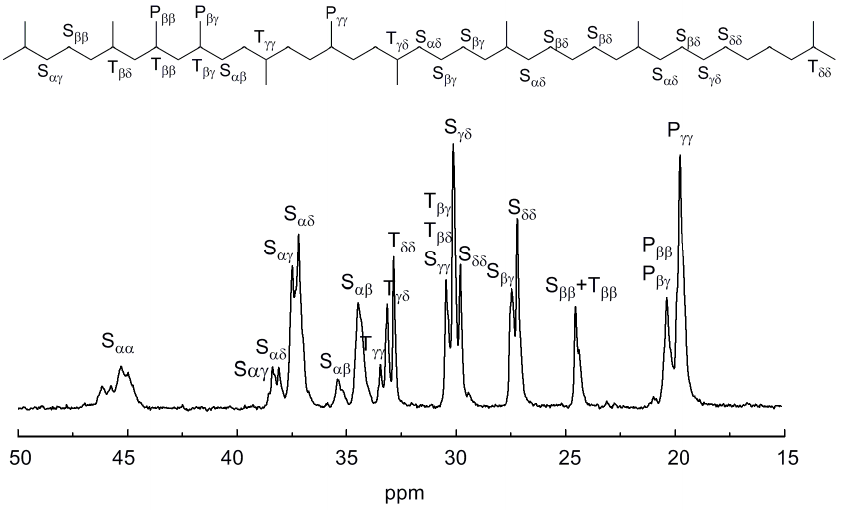
Figure 5. 13 C NMR spectrum of ethylene/propylene copolymer obtained with 1a /EASC catalyst (sample from Run 3 in Table 1).